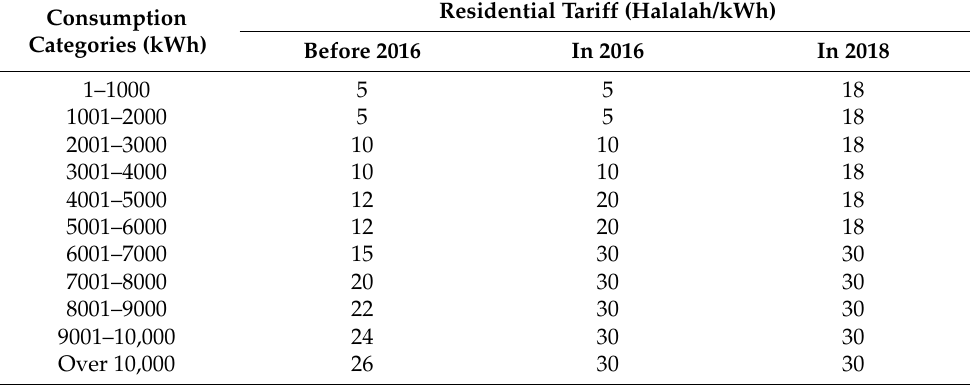
Table 1. Residential tariff